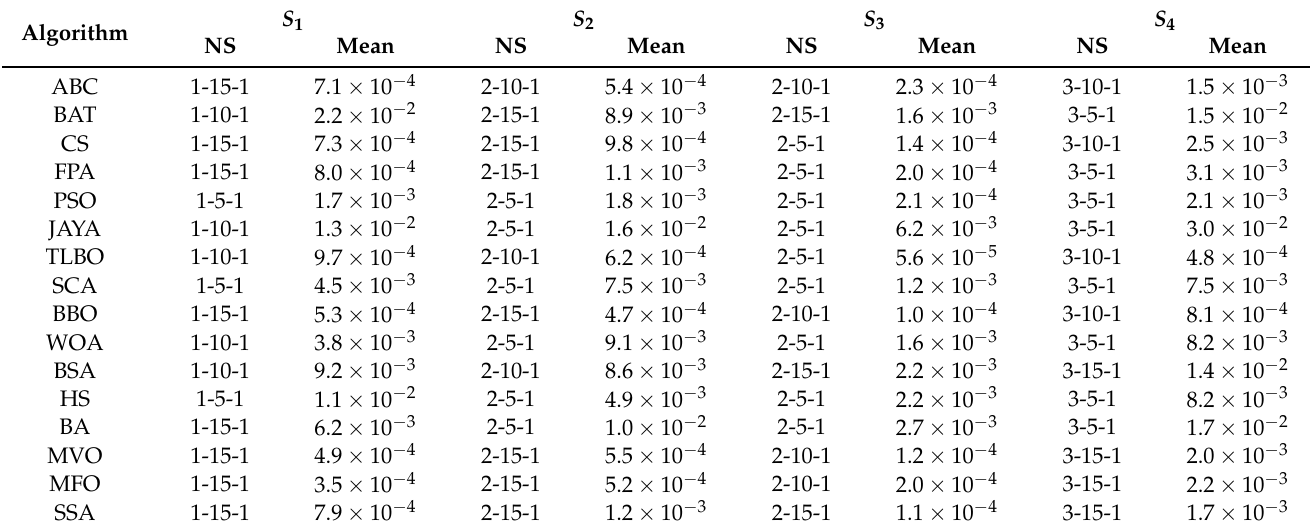
Table 8. The best training results obtained with the relevant metaheuristic algorithms for S 1 , S 2 , S 3 , and S 4 (NS: network structure).